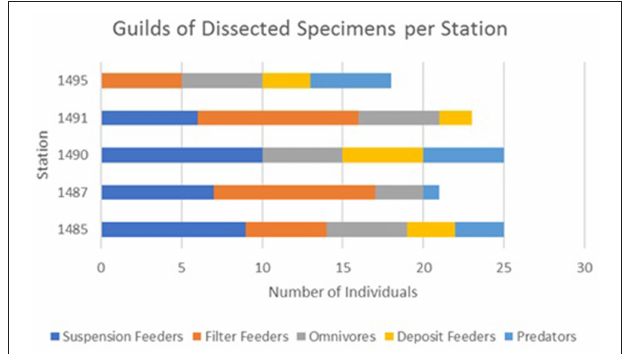
FIGURE 4 | A comparison of the individual specimen feeding guilds dissected for this experiment across reef stations.